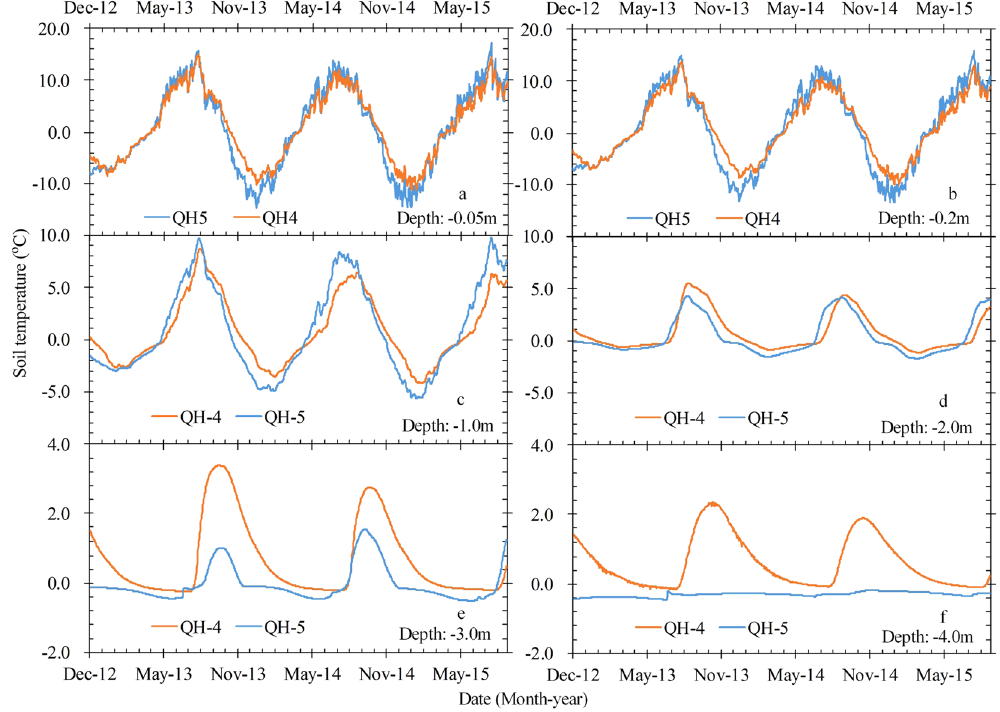
Figure 2. Variations in soil temperatures at depths of 0.05 m ( a ), 0.2 m ( b ), 1.0 m ( c ), 2.0 m ( d ), 3.0 m ( e ), and 4.0 m ( f ) at QH-4 (30 cm sand layer) and QH-5 (115 cm sand layer) in the Honglianghe River Basin during the observation period from 1 December 2012 to 28 August